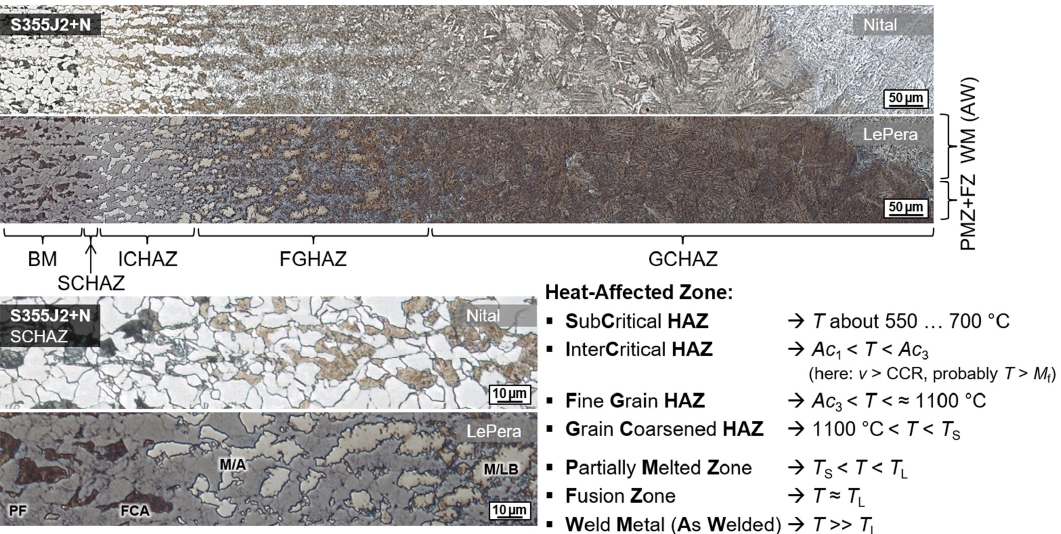
Figure 3. Exemplary HAZ microstructure of wet SMAW weldment on unalloyed structural steel S355J2+N ( WD = 0.5 m, h = 10 mm, E = 1.85